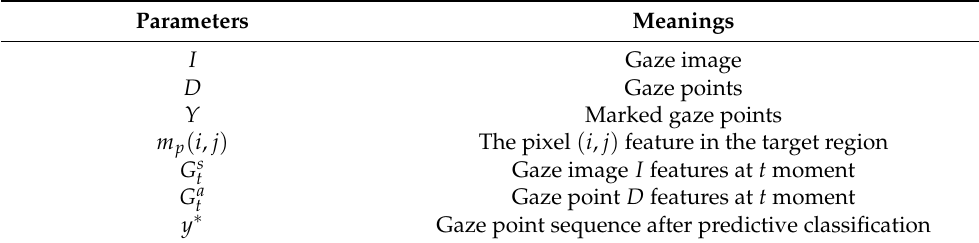
Table 2. The parameters of the proposed method.